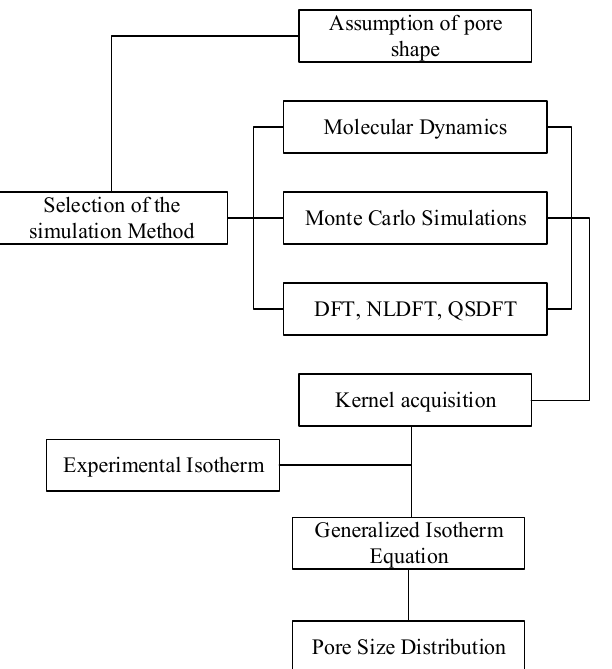
Figure 9. Diagram of the acquisition of the PSD through the application of advance inversion method. (Modified from Rouquerol et al., 2014 [58]).